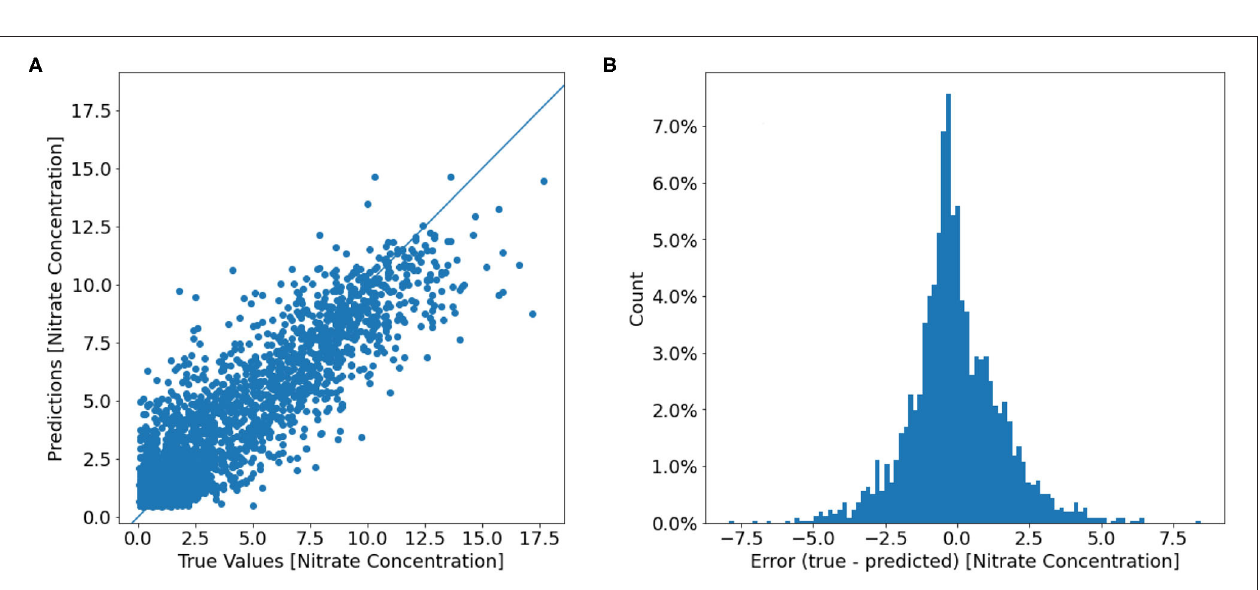
close to the mean of the temperature-salinity distribution ( Figure 8B ). The final MSE and RMSE over the test dataset for the six feature phosphate model were 0.0099 (µmol/l) 2 and 0.0995 µmol l −1 , respectively, and for the seven feature (including oxygen) were 0.0058 (µmol/l) 2 and 0.0765 µmol l −1 , respectively. For comparison, the phosphate data ranged between 0.02 and 1.80 µmol l −1 . Similarly, the MSE and RMSE over the test dataset for the six feature phosphate model were 0.78 (µmol/l) 2 and 0.89 µmol l −1 , respectively, and for the seven feature